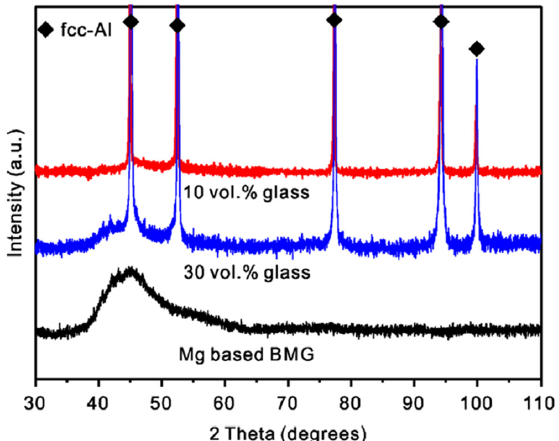
Figure 8. X-ray diffraction (XRD) patterns of the Mg 65 Cu 20 Zn 5 Y 10 glass and Al + Mg 65 Cu 20 Zn 5 Y 10 composites. Reprinted from [58], Copyright (2014), with permission from Elsevier.